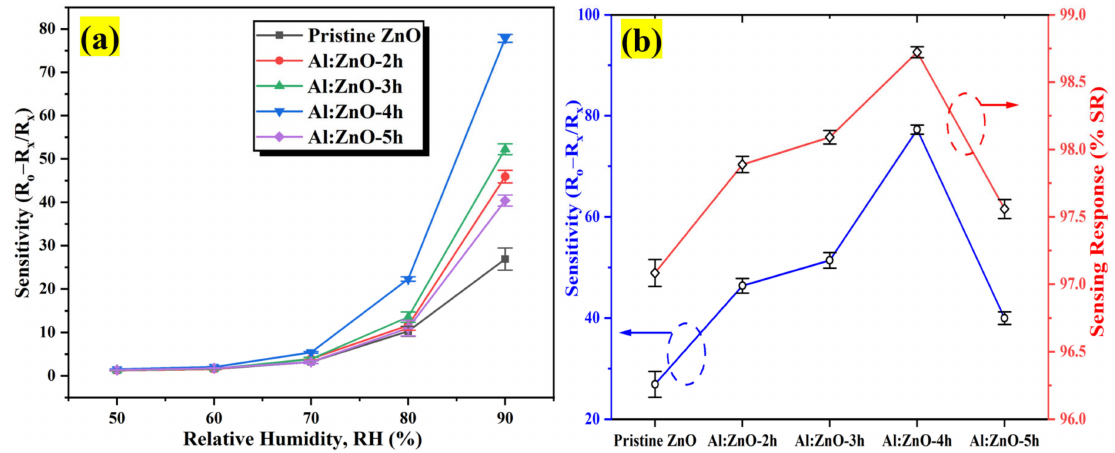
Figure 14. ( a ) Sensitivity plot of the pristine ZnO and Al:ZnO nanostructured-based flexible humidity sensors with a different immersion time of Al doping process at different humidity levels at 25 ◦ C and ( b ) sensitivity and sensing response variation of the pristine ZnO and Al:ZnO nanostructured-based flexible humidity